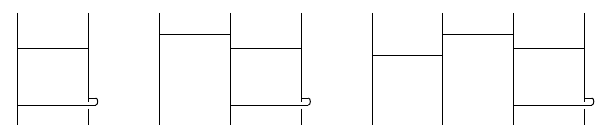
Figure 7 . Examples for simpler brane diagrams for D 2 , D 3 and D 4 quiver theories.